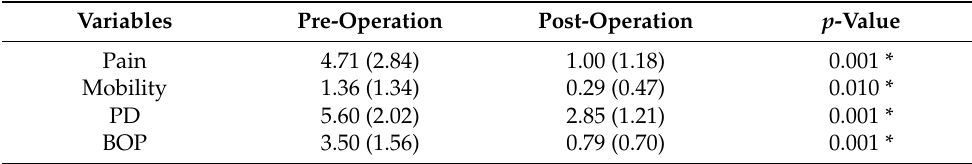
Table 3. Clinical changes between pre- and